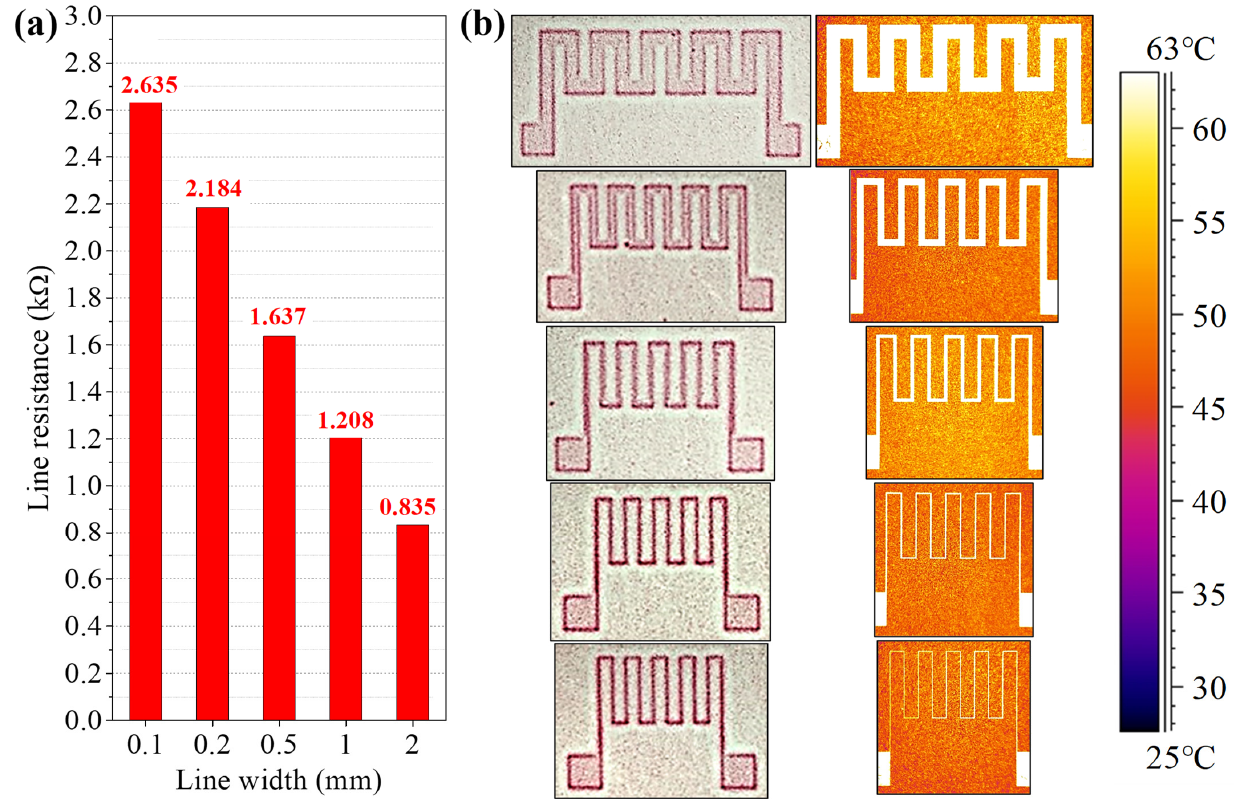
Figure 7. Zig-zag pattern for heating properties by using a continuous patterning process: ( a ) Resistance of pattern with regard to line widths of 0.1, 0.2, 0.5, 1, and 2 mm. ( b ) Picture of pressure-sensitive paper to check the selective calendering part ( left ), and far infrared camera thermal image for temperature distribution by Joule heating under an operating voltage of 5 V ( right ).